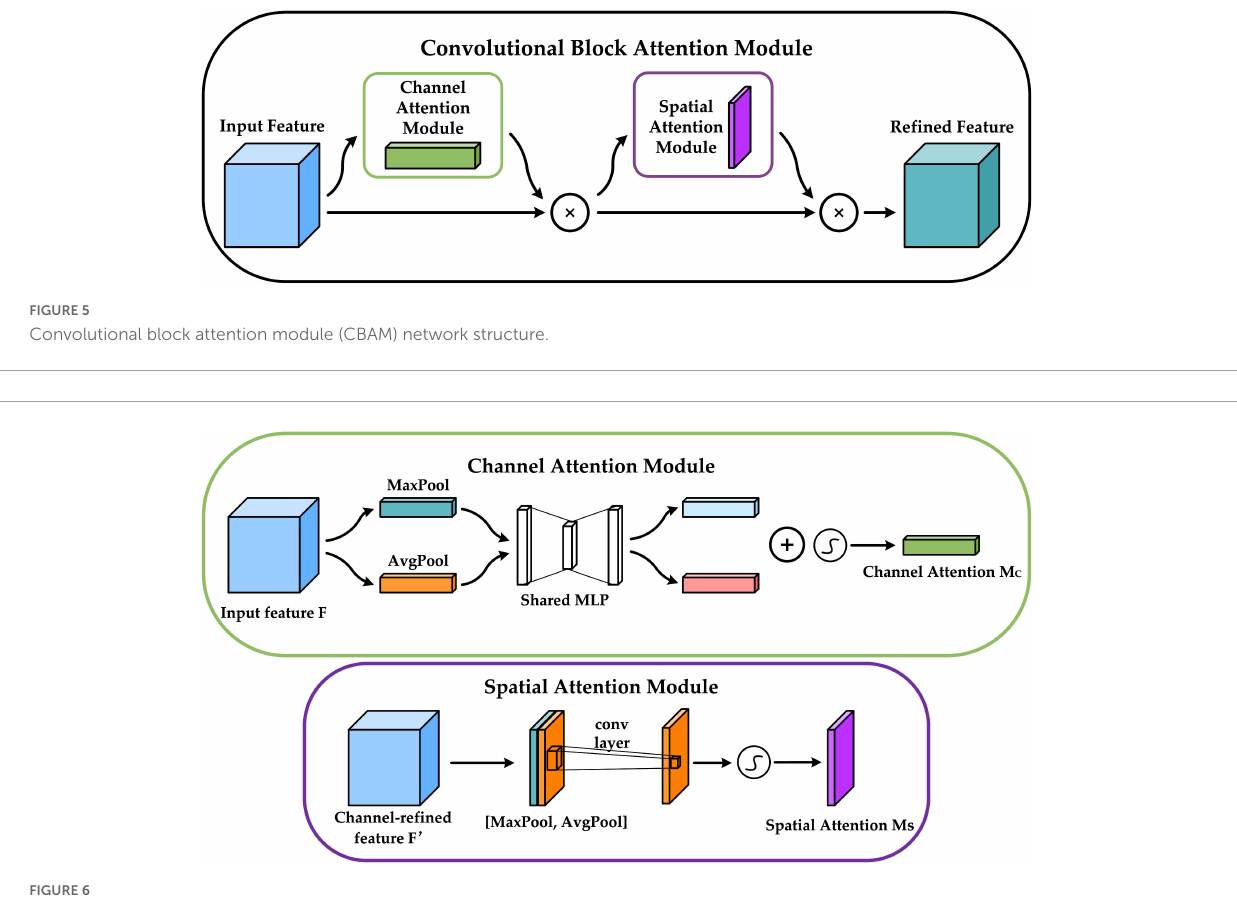
FIGURE6 Structure of channel attention module and spatial attention